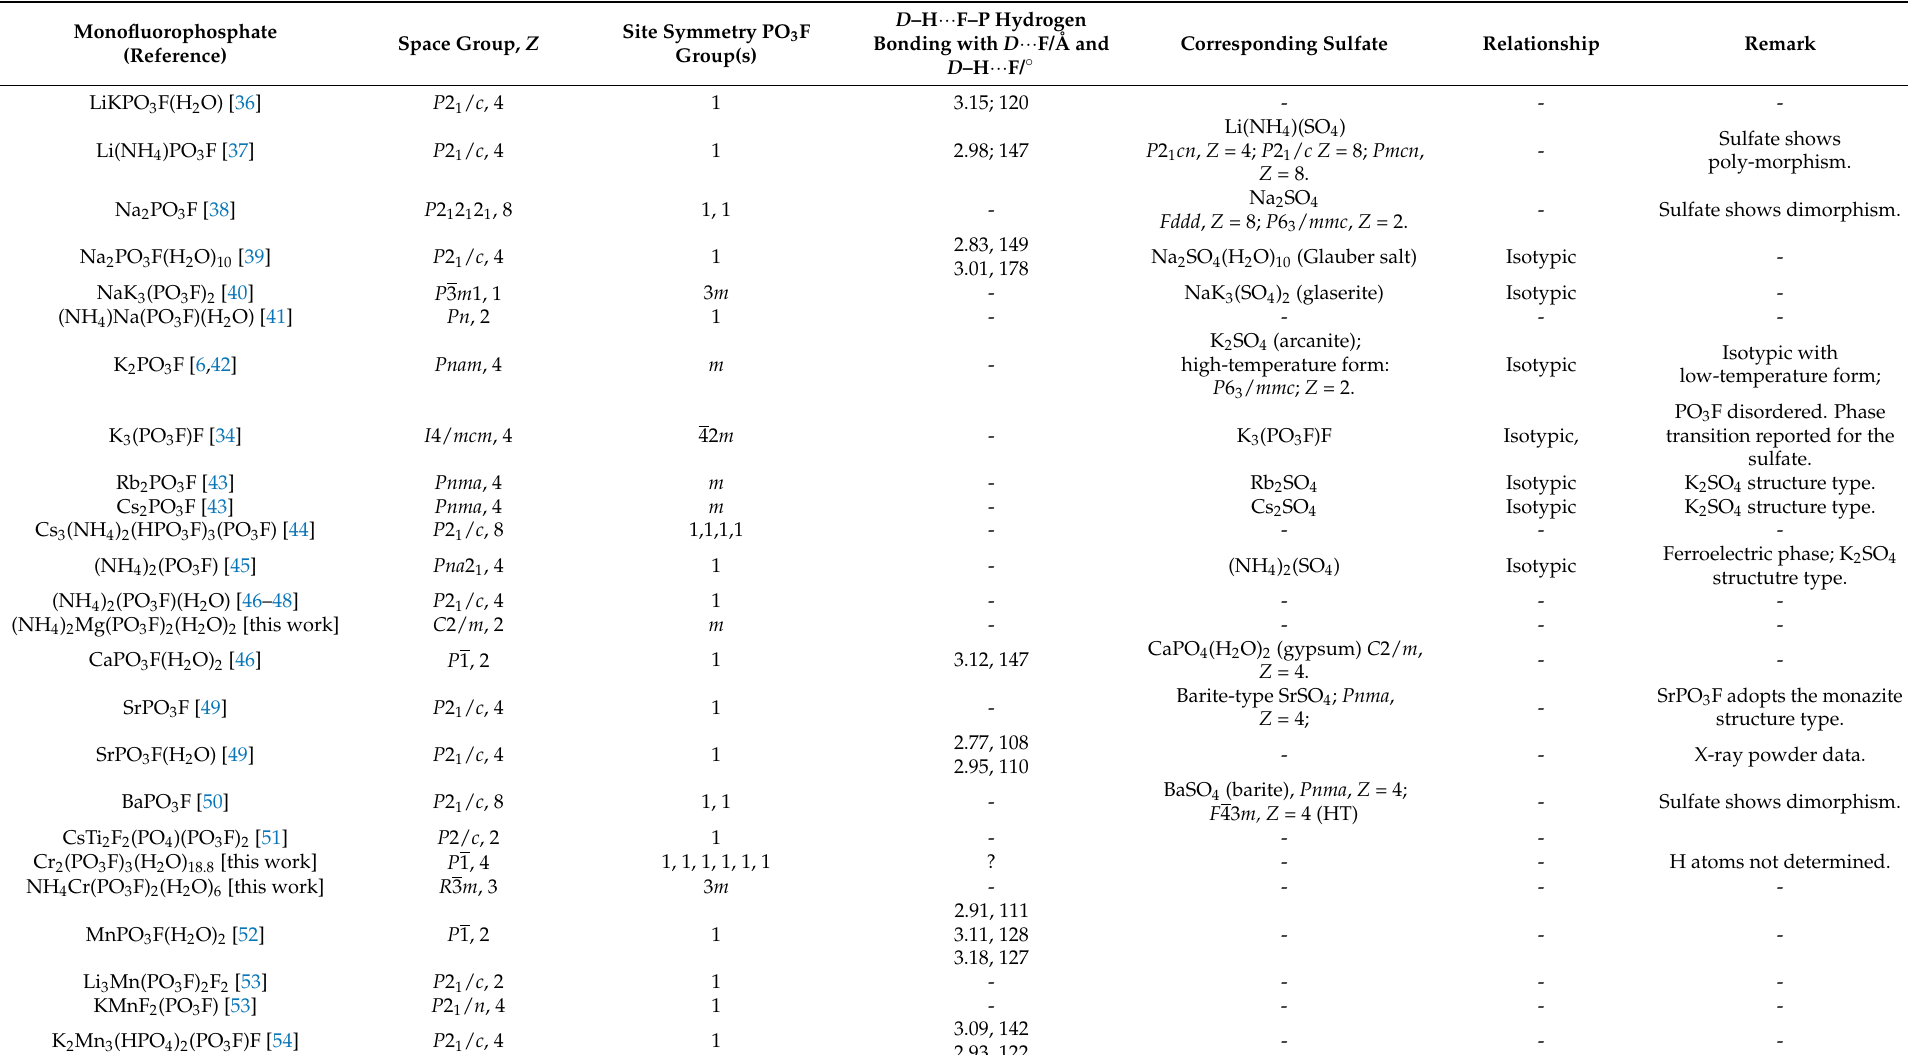
Table 5. Structural details of monofluorophosphates, site symmetries of corresponding PO 3 F tetrahedra, relation to the sulfate analogues and details of D –H ··· P–F hydrogen